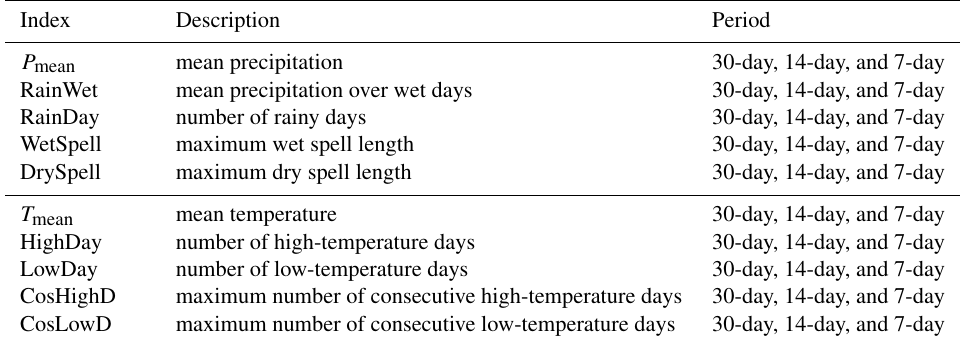
Table 3. Precipitation and temperature indices used in this study.